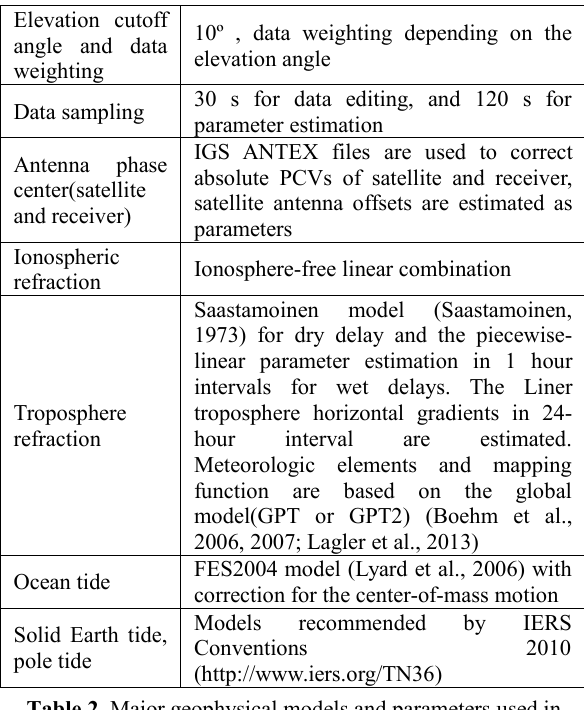
Table 2 . Major geophysical models and parameters used in GAMIT GNSS data